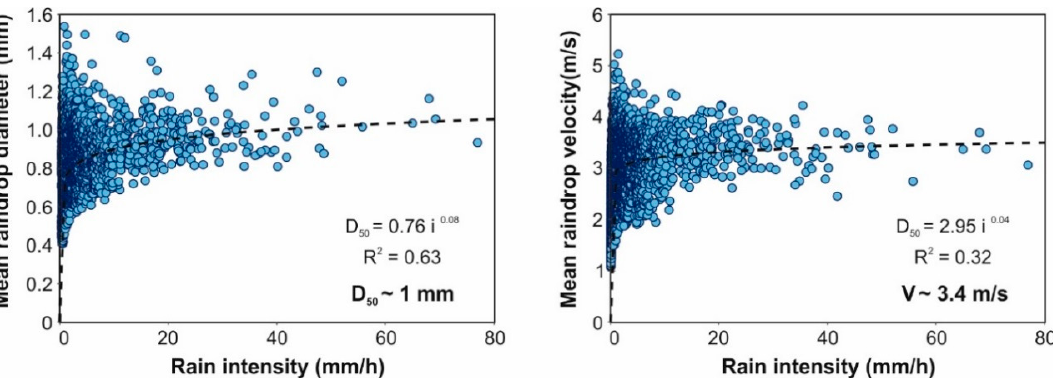
Figure 4. Relation of raindrop mean diameter and velocity with respect to the rain intensity measured by the disdrometer.